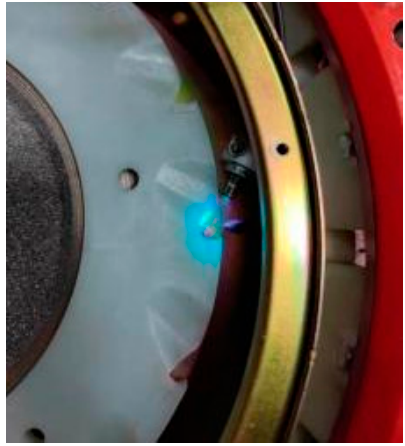
Figure 3. Sensor installation diagram.